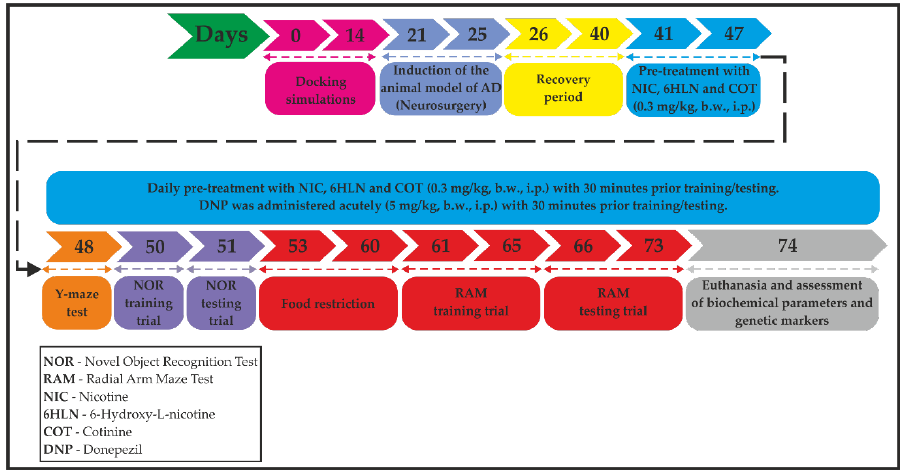
Figure 2. A flowchart showing the timeline and experimental design.